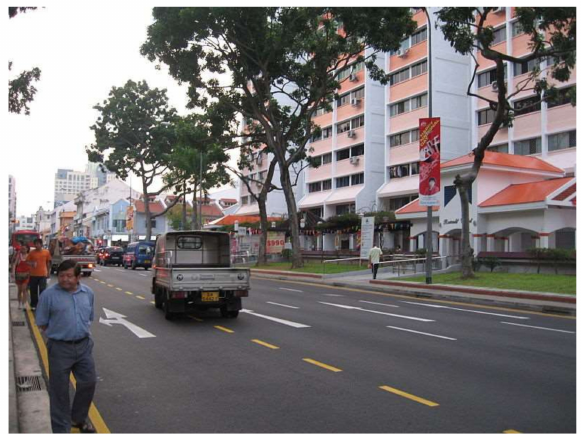
Figure 2. Modern-day Jalan Besar (Terence Ong, https: // commons.wikimedia.org / wiki / File:Jalan_Besar_